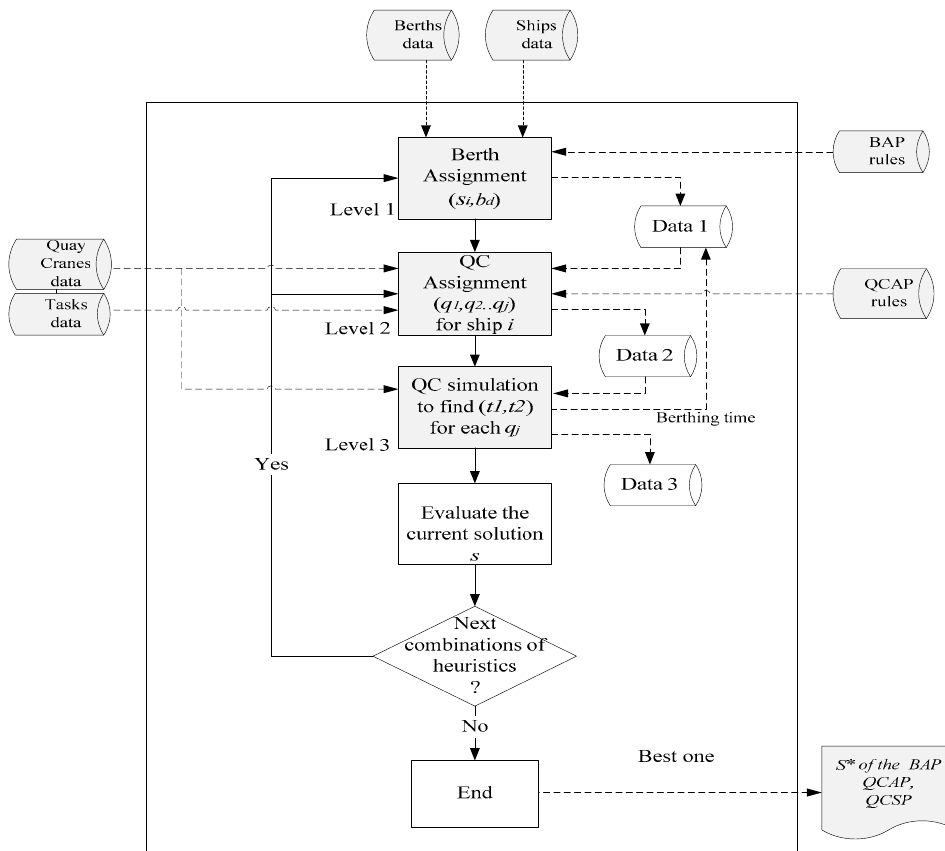
Figure 1. The input and output of the three ‐ level framework of heuristics for simulation. Data